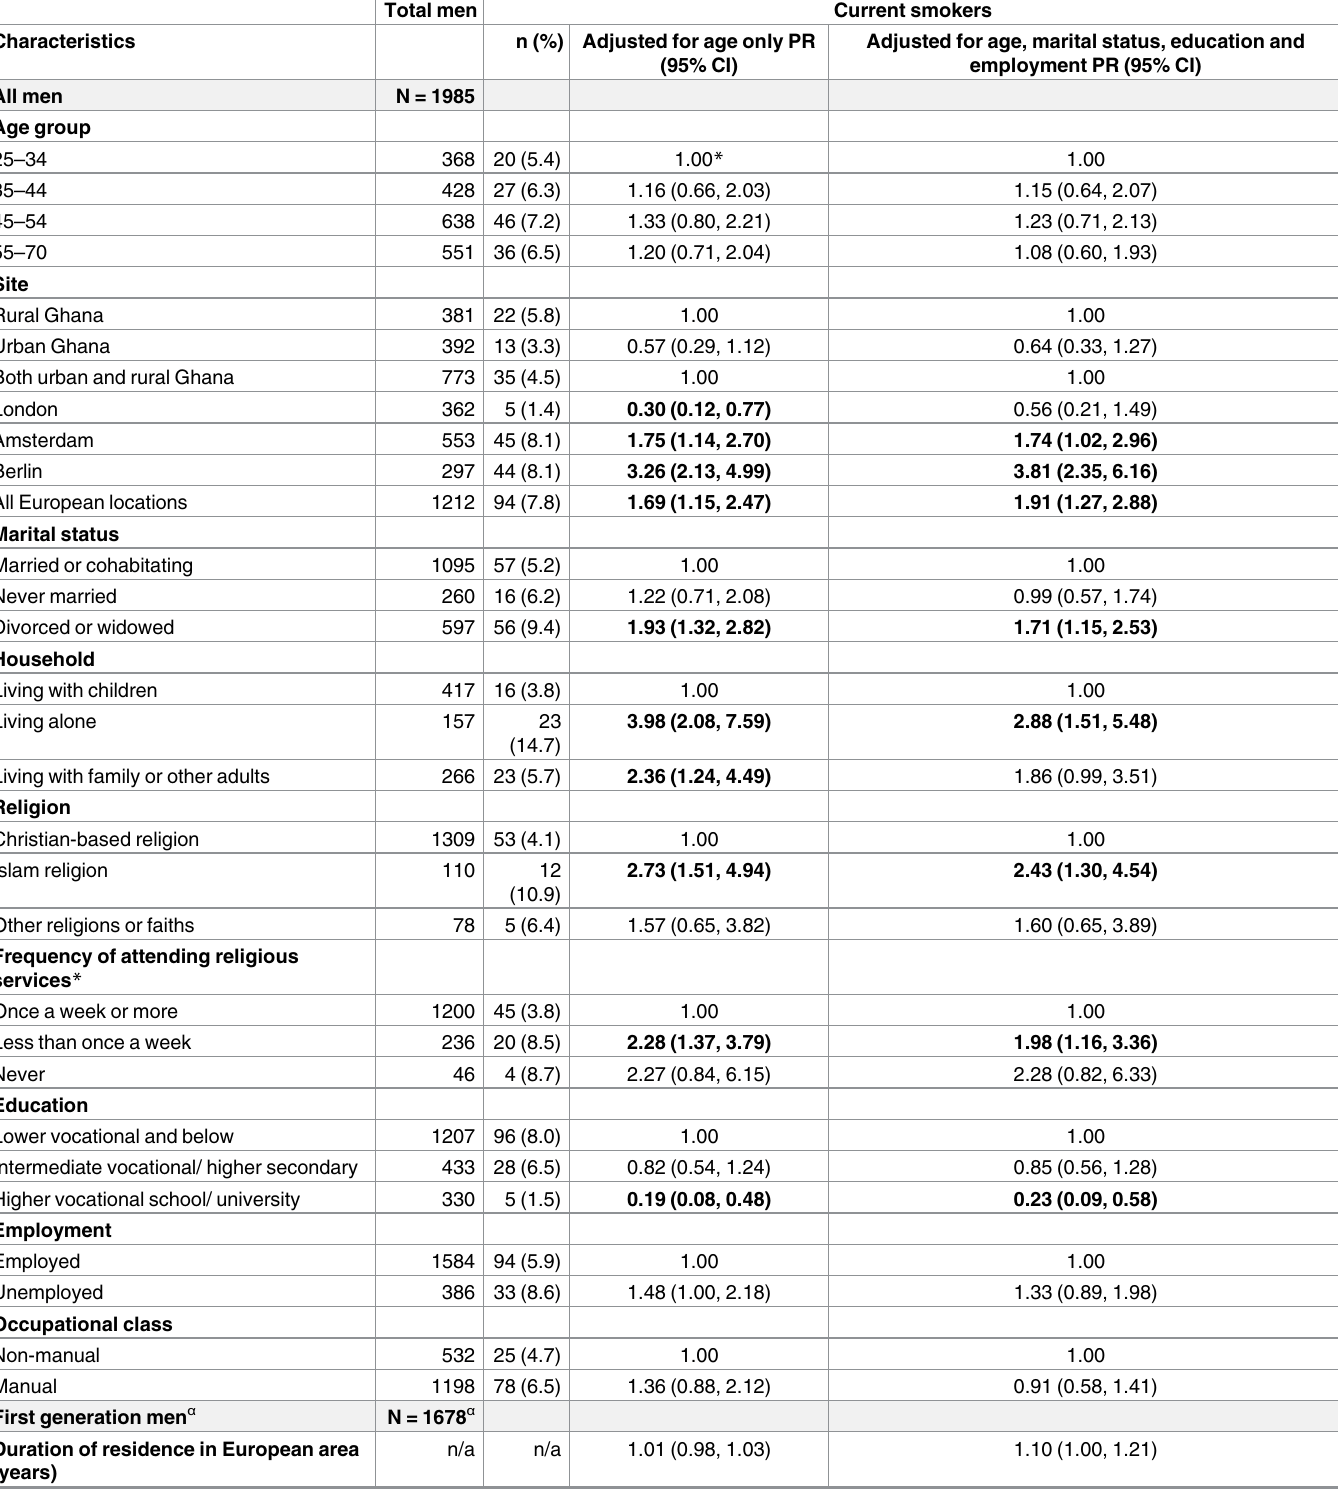
Table 2. Factors associated with current smoking among Ghanaian men in all locations. Total